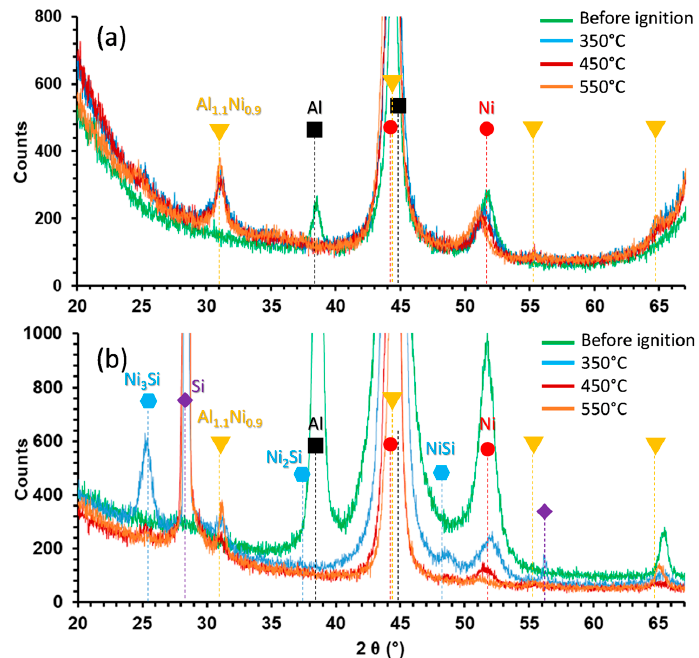
Figure 5. XRD Theta-2Theta curve of RTA treated samples with 1 µm RML thickens, ( a ) on black silicon surface; ( b ) reference on flat wafer. Identification peaks are associated to PDF 03-065-2869 (fm-3m Al), 03-065-2865 (fm-3m Ni), and 00-044-1187 (pm-3m Al 1.1 Ni 0.9 ).